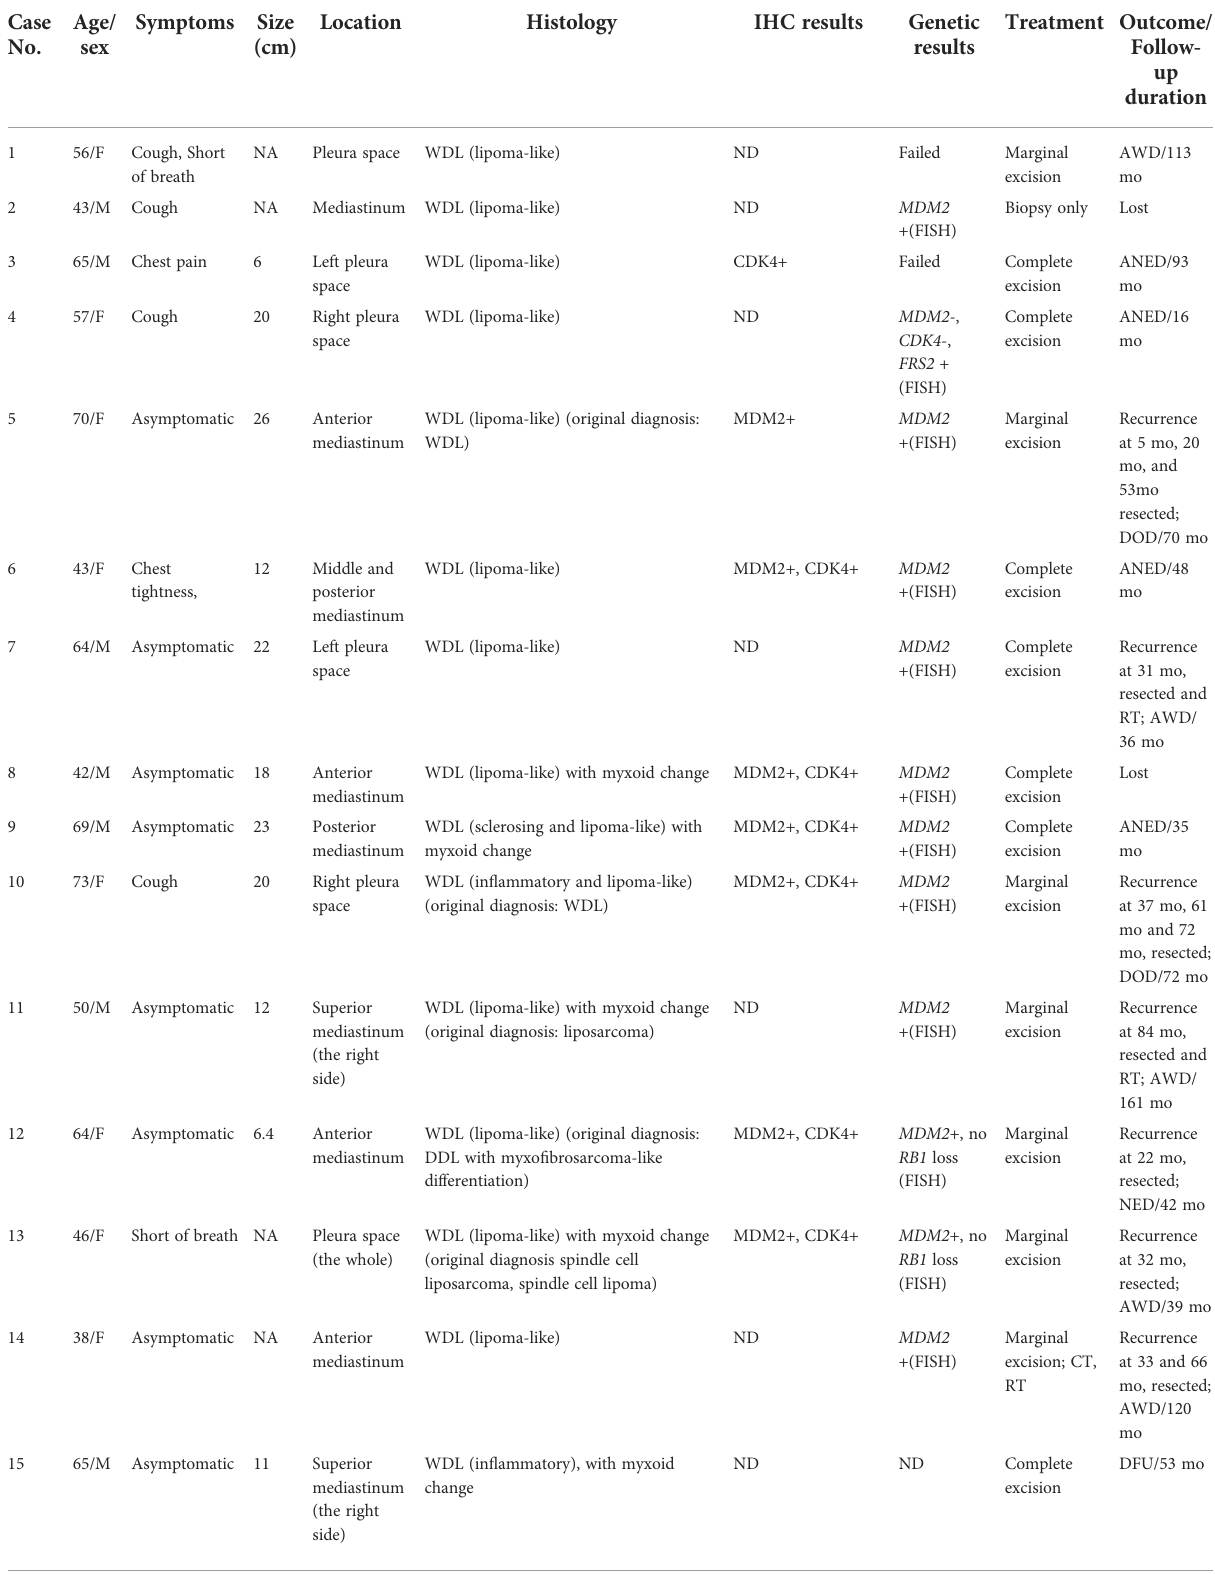
TABLE 1 Clinicopathologic features of 43 primary intrathoracic liposarcomas. Case